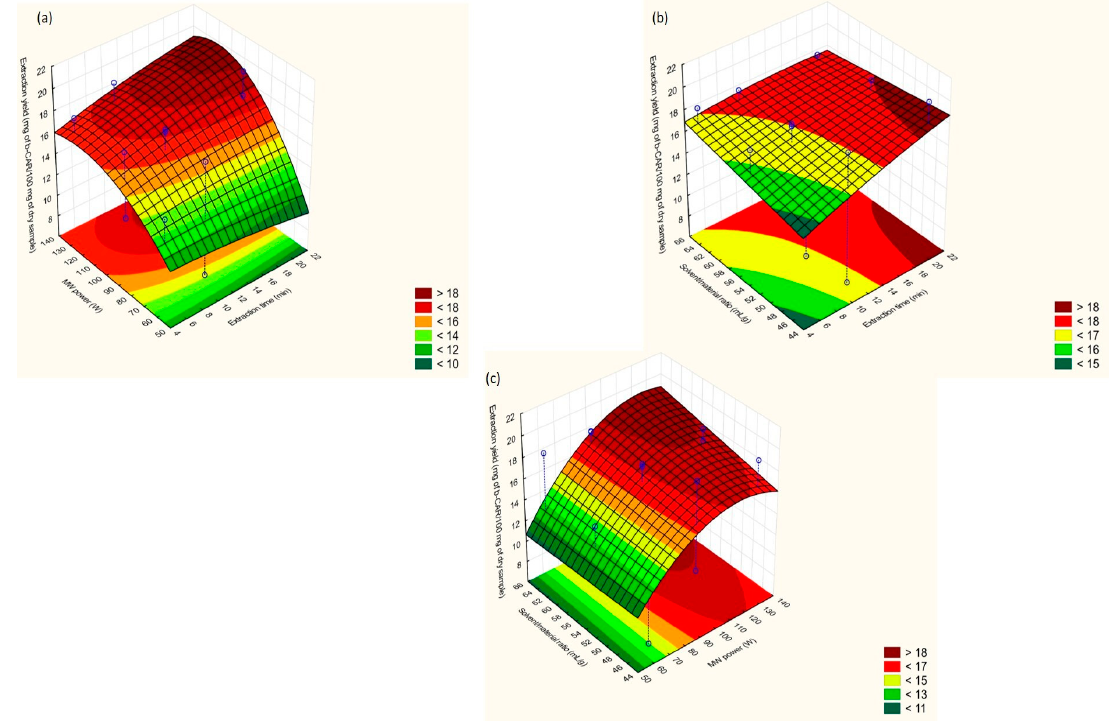
Figure 4. RSM plots for MAE: ( a ) extraction time vs. MW power; ( b ) MW power vs. solvent/material ratio; ( c ) solvent/material ratio vs. extraction time.